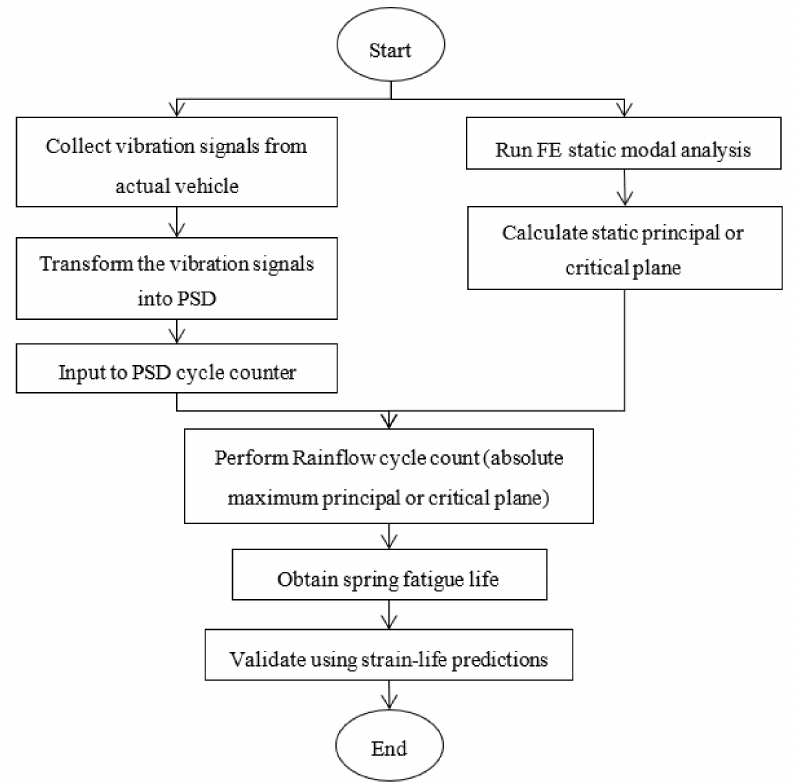
Figure 1. Process flow for coil spring vibration fatigue